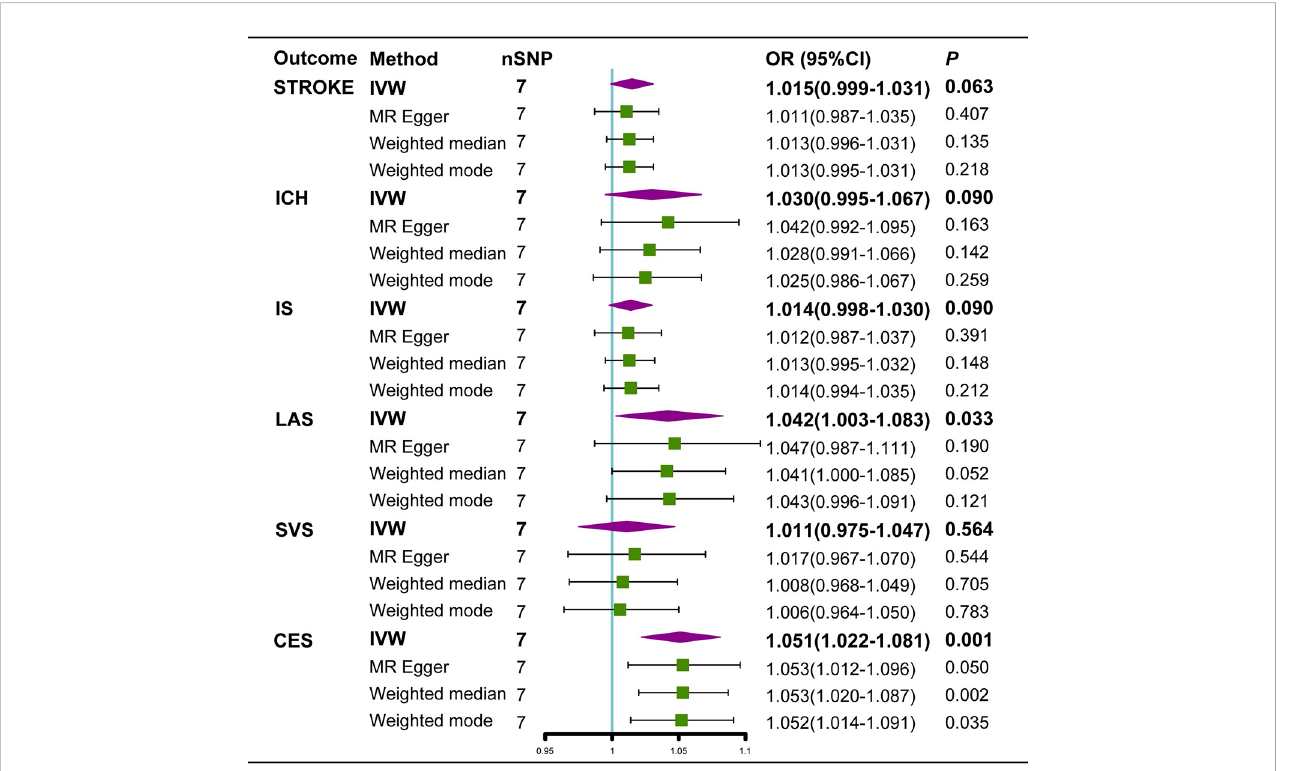
FIGURE 2 Estimated causal effects of AS on stroke using different MR methods. ICH, intracerebral hemorrhage; IS, Ischemic stroke; LAS, large artery atherosclerosis; SVS, small vessel stroke; CES cardioembolic stroke; Cl, con fi dence interval; IVW, inverse variance weighted; MR-Egger, Mendelian randomization-Egger; SNPs, single nucleotide polymorphisms.